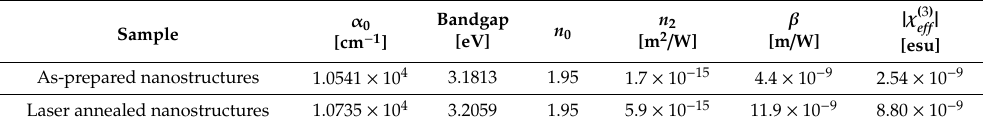
Table 1. Optical